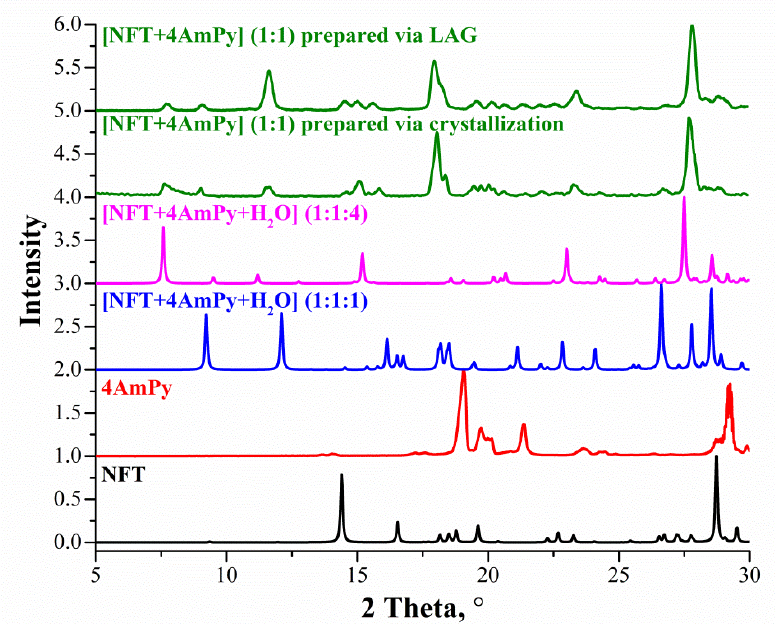
Figure 5. Experimental PXRD pattern of [NFT+4AmPy] salt (1:1) prepared via crystallization and LAG in the presence of acetonitrile compared to the parent compounds and simulated PXRD patterns for the NFT hydrated salts.